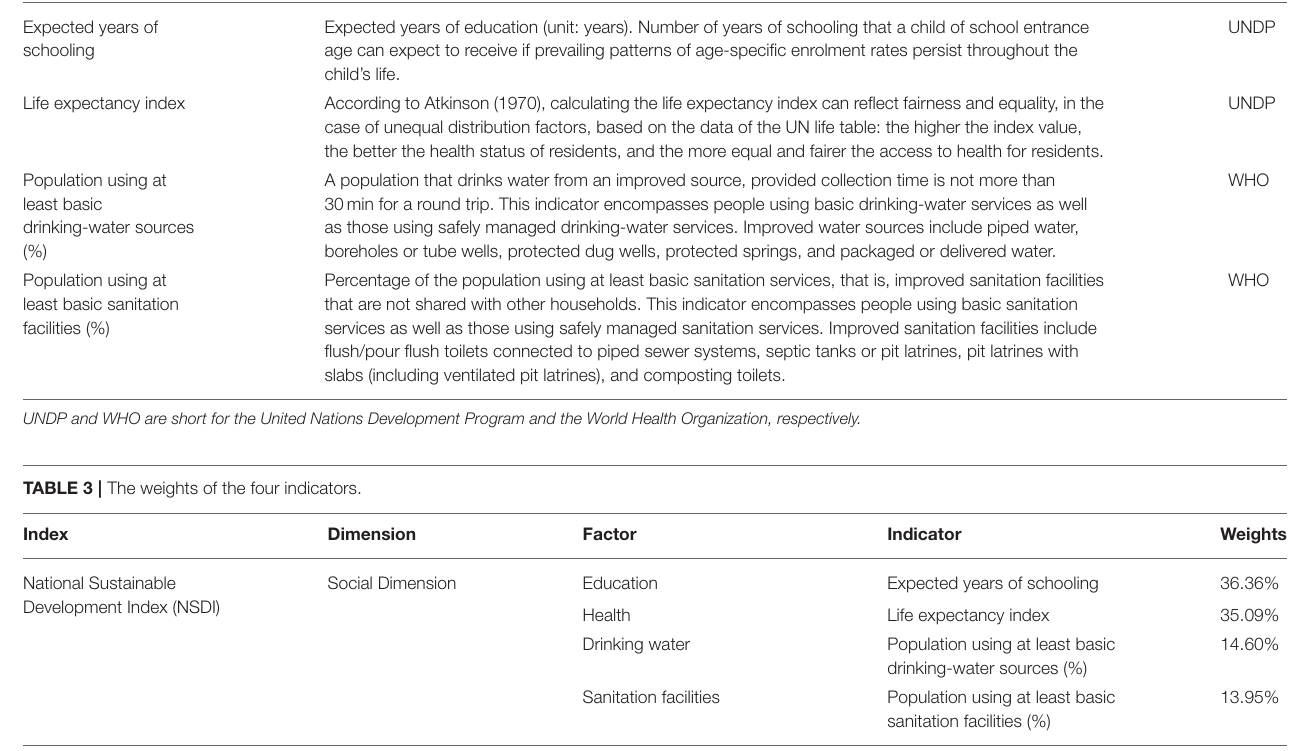
TABLE 2 | The descriptions and data sources of the four indicators in the social dimension of the NSDI. Indicator